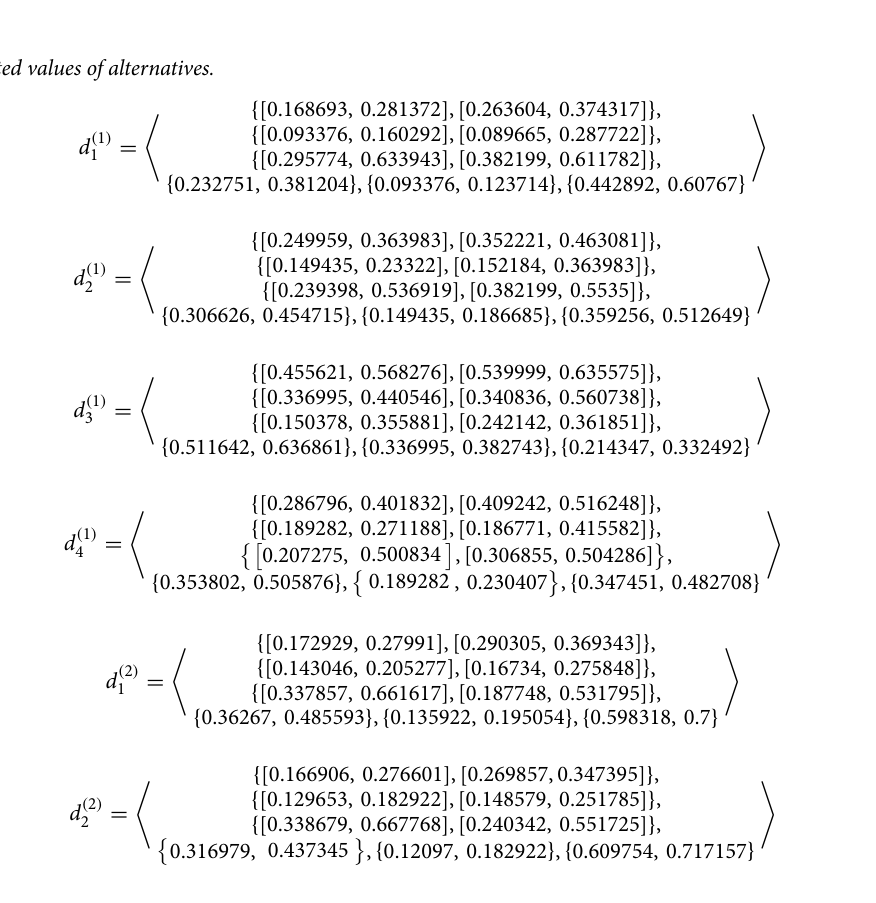
Table 1. Comparison of the